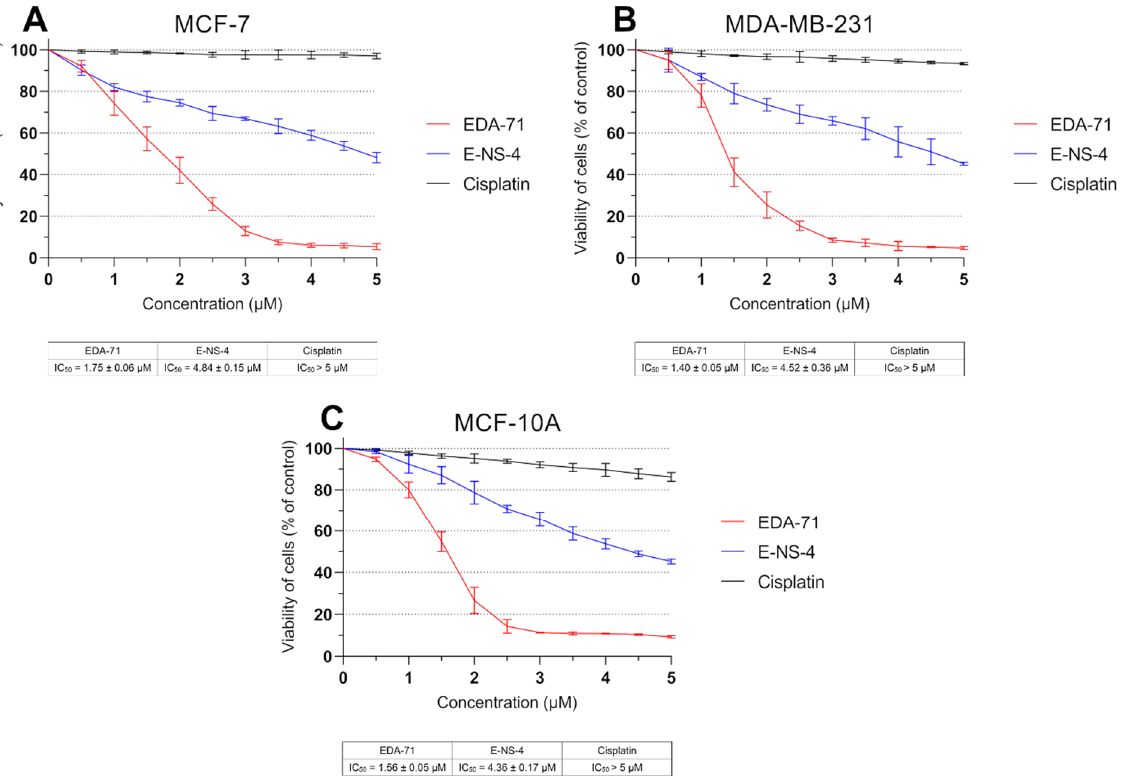
Figure 2. Viability of MCF-7 ( A ) and MDA-MB-231 ( B ) breast cancer cells and MCF-10A normal breast epithelial cells ( C ) incubated for 24 h with the tested compounds and cisplatin at various concentrations. Results are presented as mean values (percent of untreated cells) ± SD obtained from three independent experiments ( n = 3) conducted in triplicate.